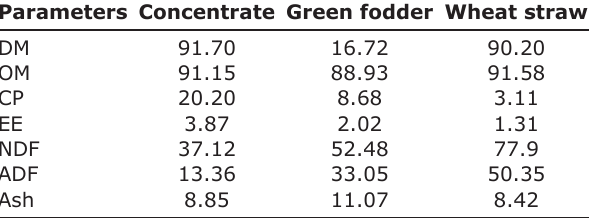
Table-2: Chemical composition of feed offered (%DM basis).